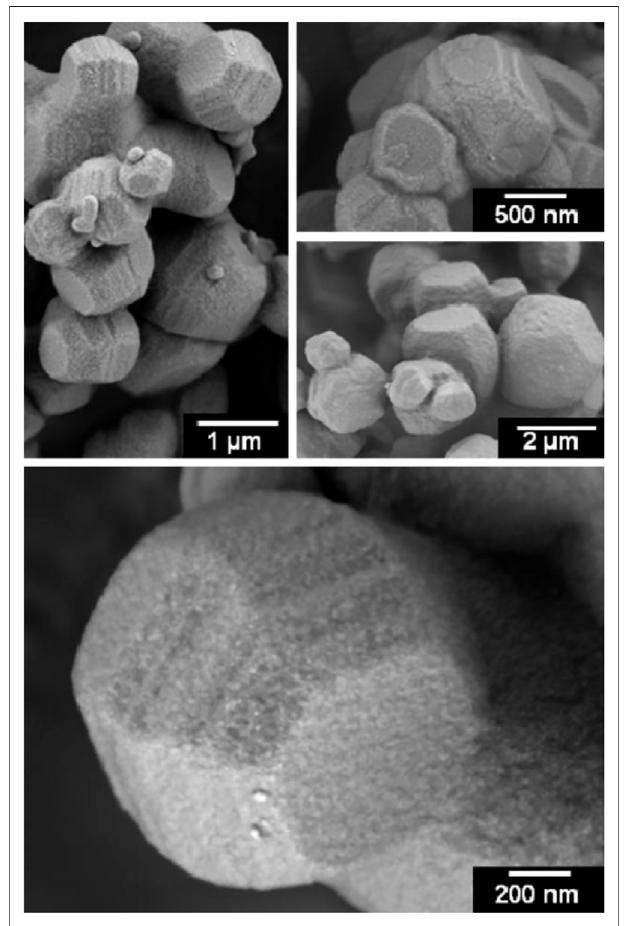
FIGURE17| HRSEMimagesofCOK-19(reprintedwithpermissionfrom Kerkhofs et al., 2015b, Copyright 2015 American Chemical Society).